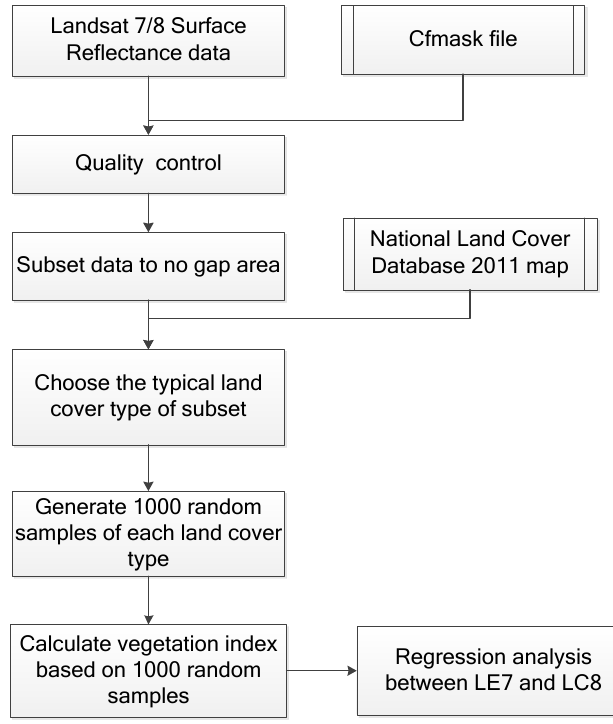
Figure 4. Flow diagram of the satellite data processing performed in this